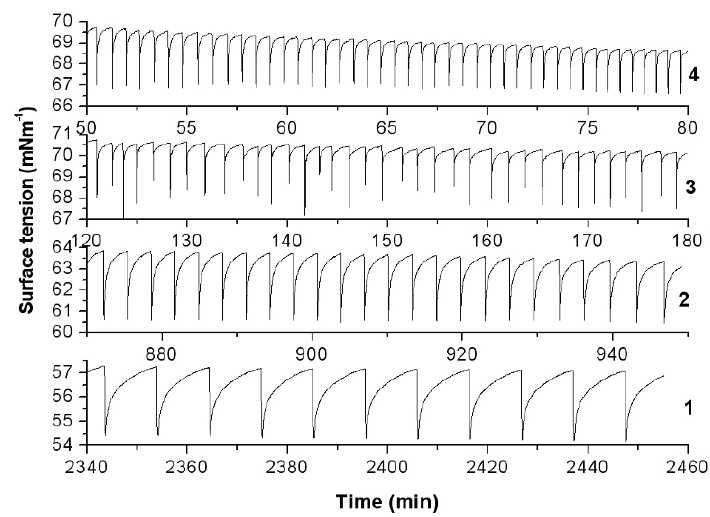
Figure 7. Oscillations of the surface tension produced by various aliphatic alcohols: 1 – octanol, d=45 mm, h=6.1 mm; 2 – heptanol, d=57 mm, h=10.9 mm; 3 – hexanol, d=57 mm, h=13.3 mm; 4 – pentanol, d=37 mm, h=13.7